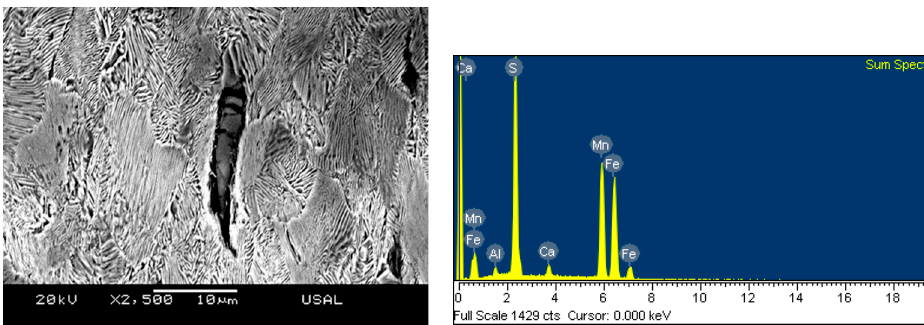
Figure 4. Inclusion of soft -type, with main composition of manganese sulfide, belonging to the E2 steel (second drawing step).